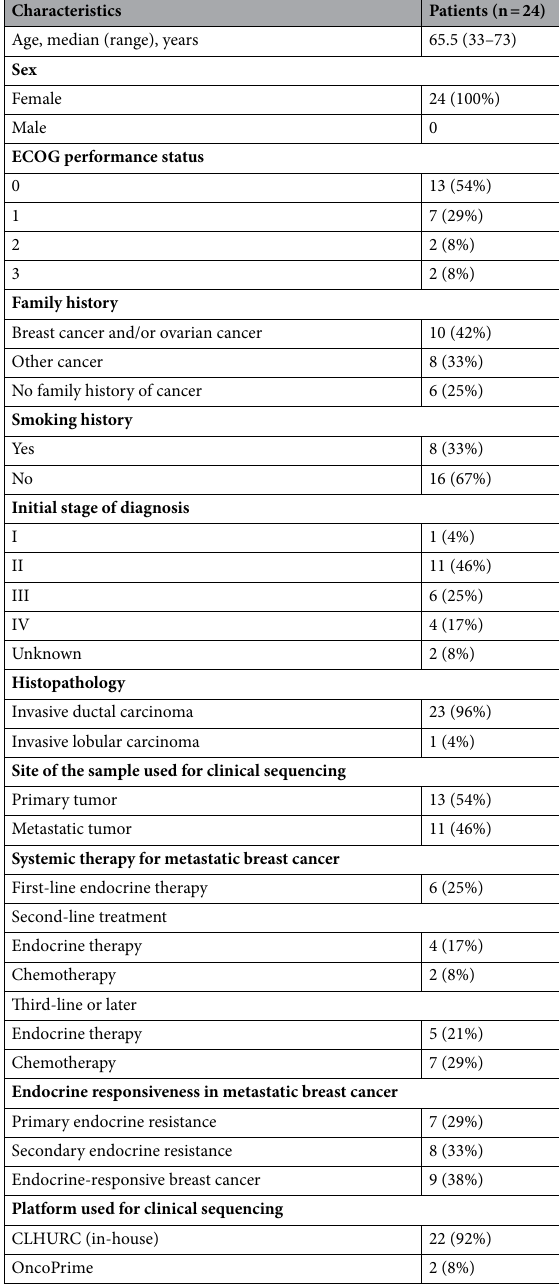
Table 1. Characteristics of patients at the time of clinical